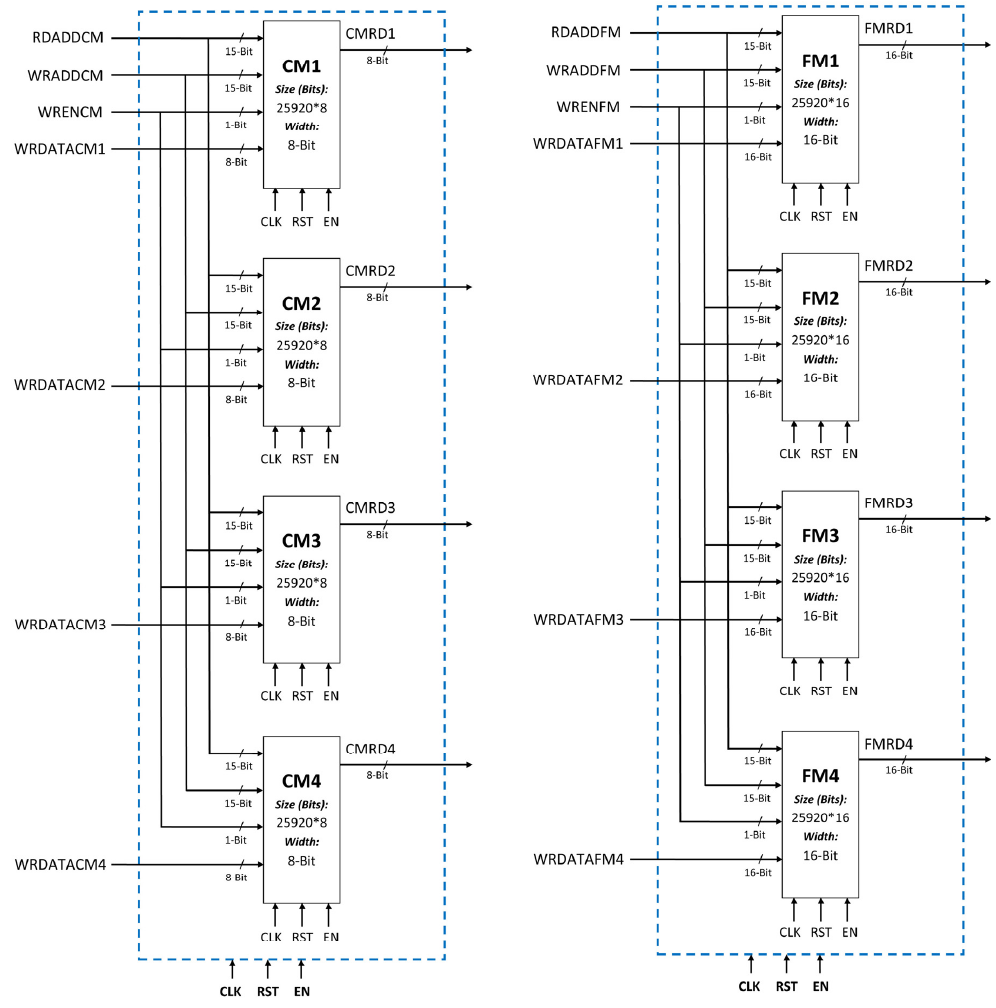
Figure 8. Parameter Memory (Centroid and Frame Number) of Motion Detection Architecture.